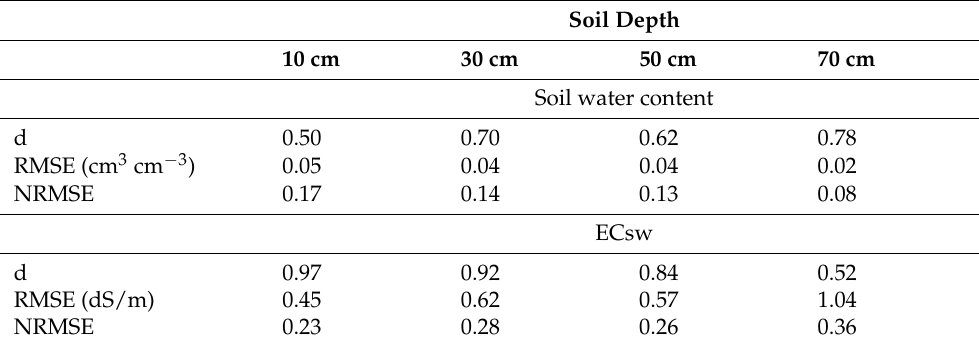
Figure 6. Time series of the simulated soil water content during the growing season and out of the growing season with observational measurements at ( a ) 10, ( b ) 30, ( c ) 50, and ( d ) 70 cm soil depth. Table 9. Statistical indices to evaluate the performance of the -1D model regarding simulating soil water